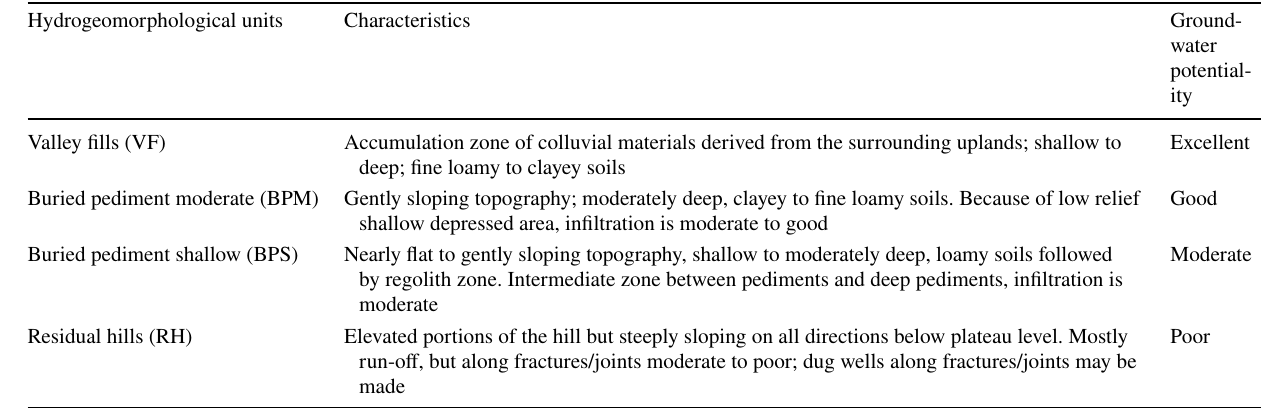
Fig. 4 Hydrogeomorphic units of the study